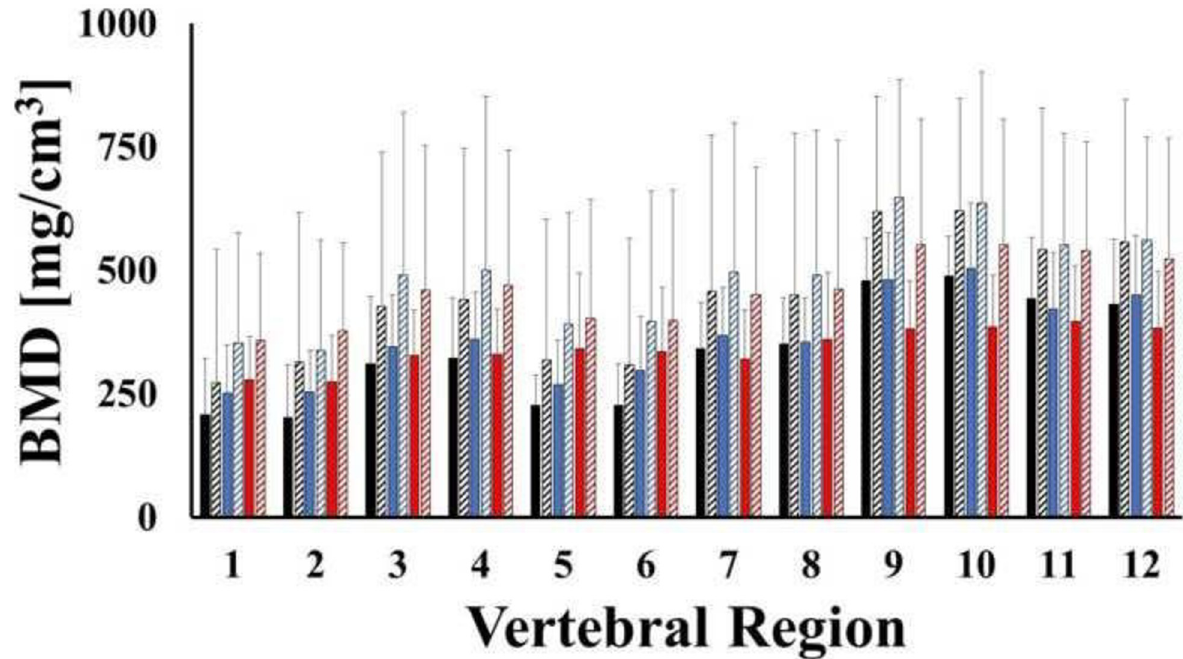
Fig 7. Mean values of bone mineral density across regions of C3 (black), C4 (blues) and C5 (red) for male (solid) and female (stripes) samples. Bars indicate one standard deviation.